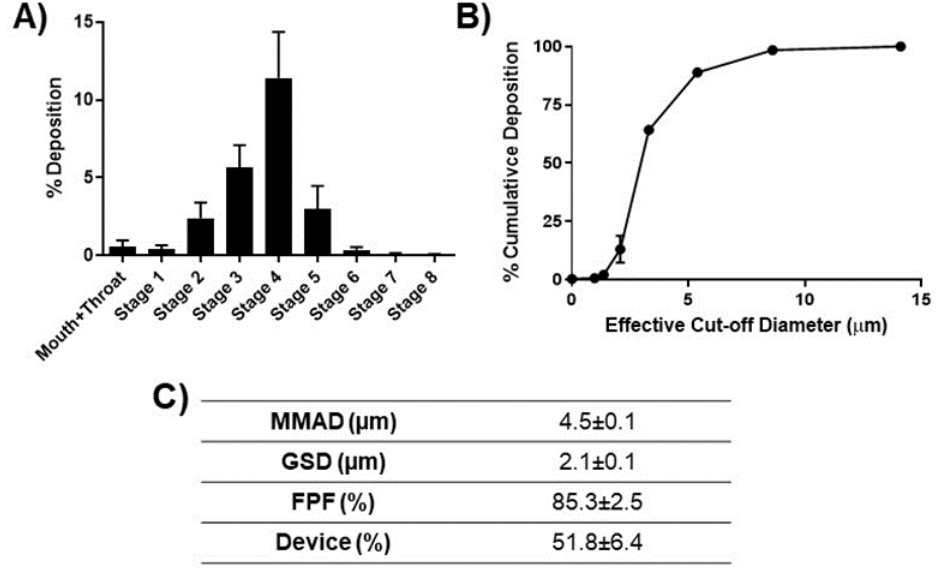
Figure 3. In vitro aerosol performance of Cela MP. ( A ). Aerodynamic deposition of Cela MPs in various stages of a Next-Gen Impactor TM (NGI). ( B ). Percent cumulative deposition as a function of effective cut-off diameter of Cela MPs. ( C ). Summary of aerosolization parameters calculated from using NGI. Data represent mean ± SEM (n = 3).